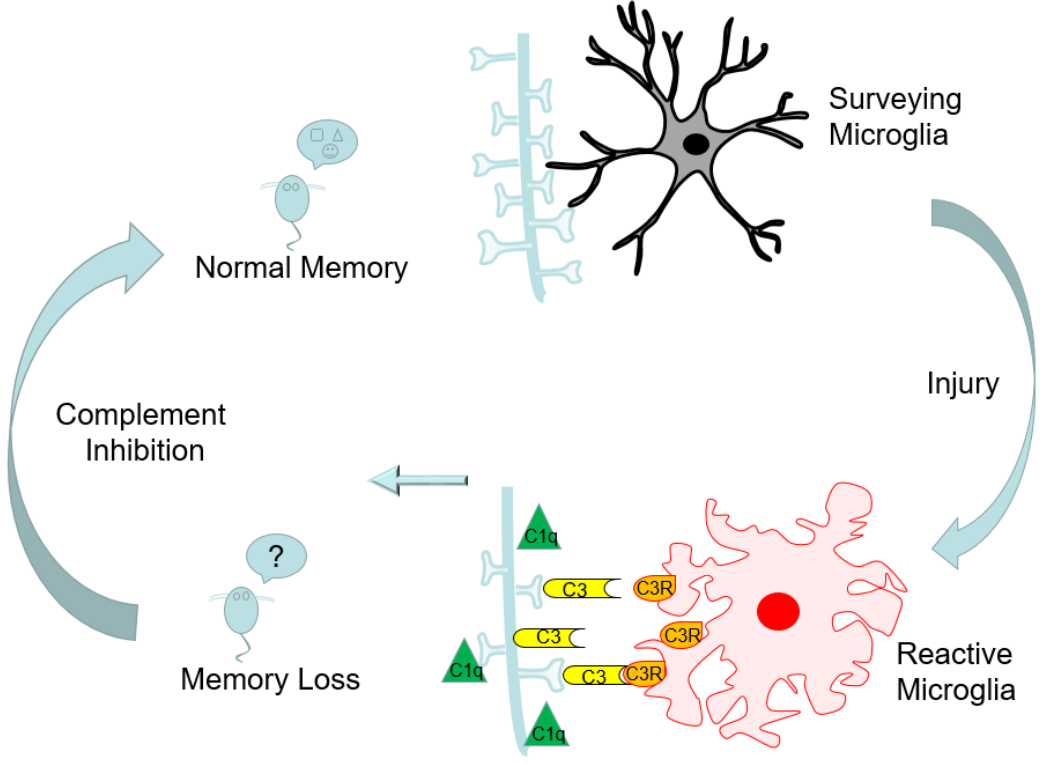
Figure 7. Schematic diagram of the working model. Normal memory function in mice corresponds with numerous synapses and surveying microglia in the hippocampus, the brain region responsible for forming new memories. Traumatic brain injury causes activation of microglia and long-lasting increases in the expressions of C1q and C3 at the synapses in the hippocampus. Microglia expressing the C3R receptor move in and bind the C3-tagged synapses, resulting in phagocytosis of the synapse. The combination of activated microglia and complement-mediated neuronal tagging results in synapse loss in the hippocampus and consequent memory loss. Genetic or pharmacological intervention of the complement pathway prevents trauma-induced memory deficits.